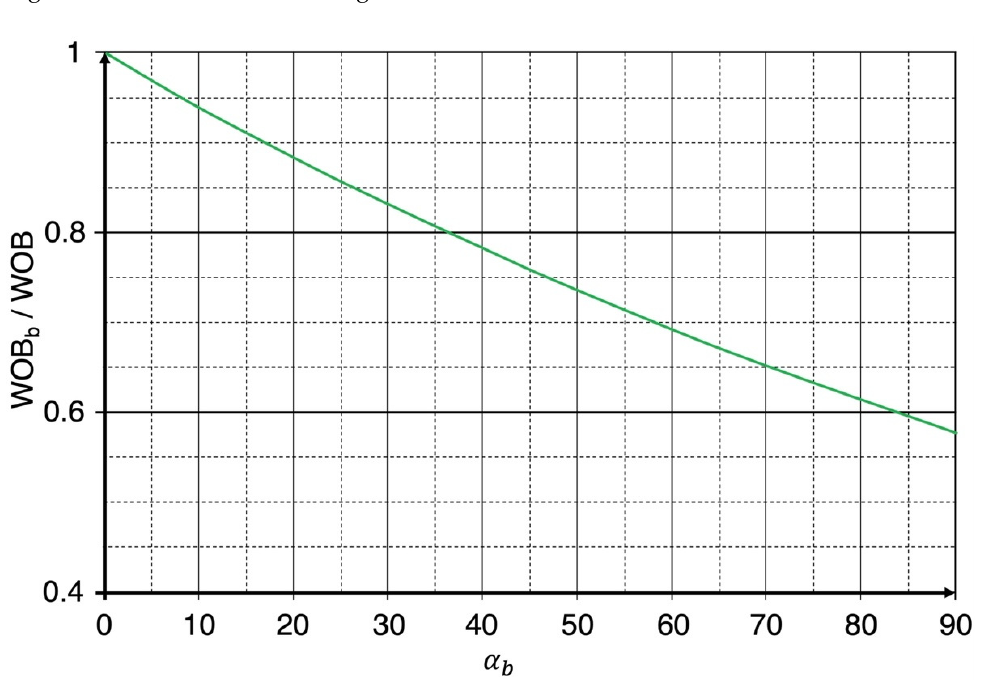
Figure 5. Relationship between WOB ratio and bottom hole deviation angle .